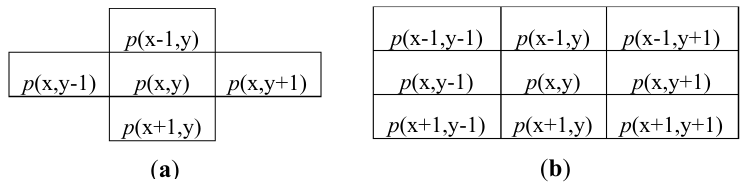
Figure 1. Pixel connectivity for a four-connected ( a ) and an eight-connected ( b ) set.